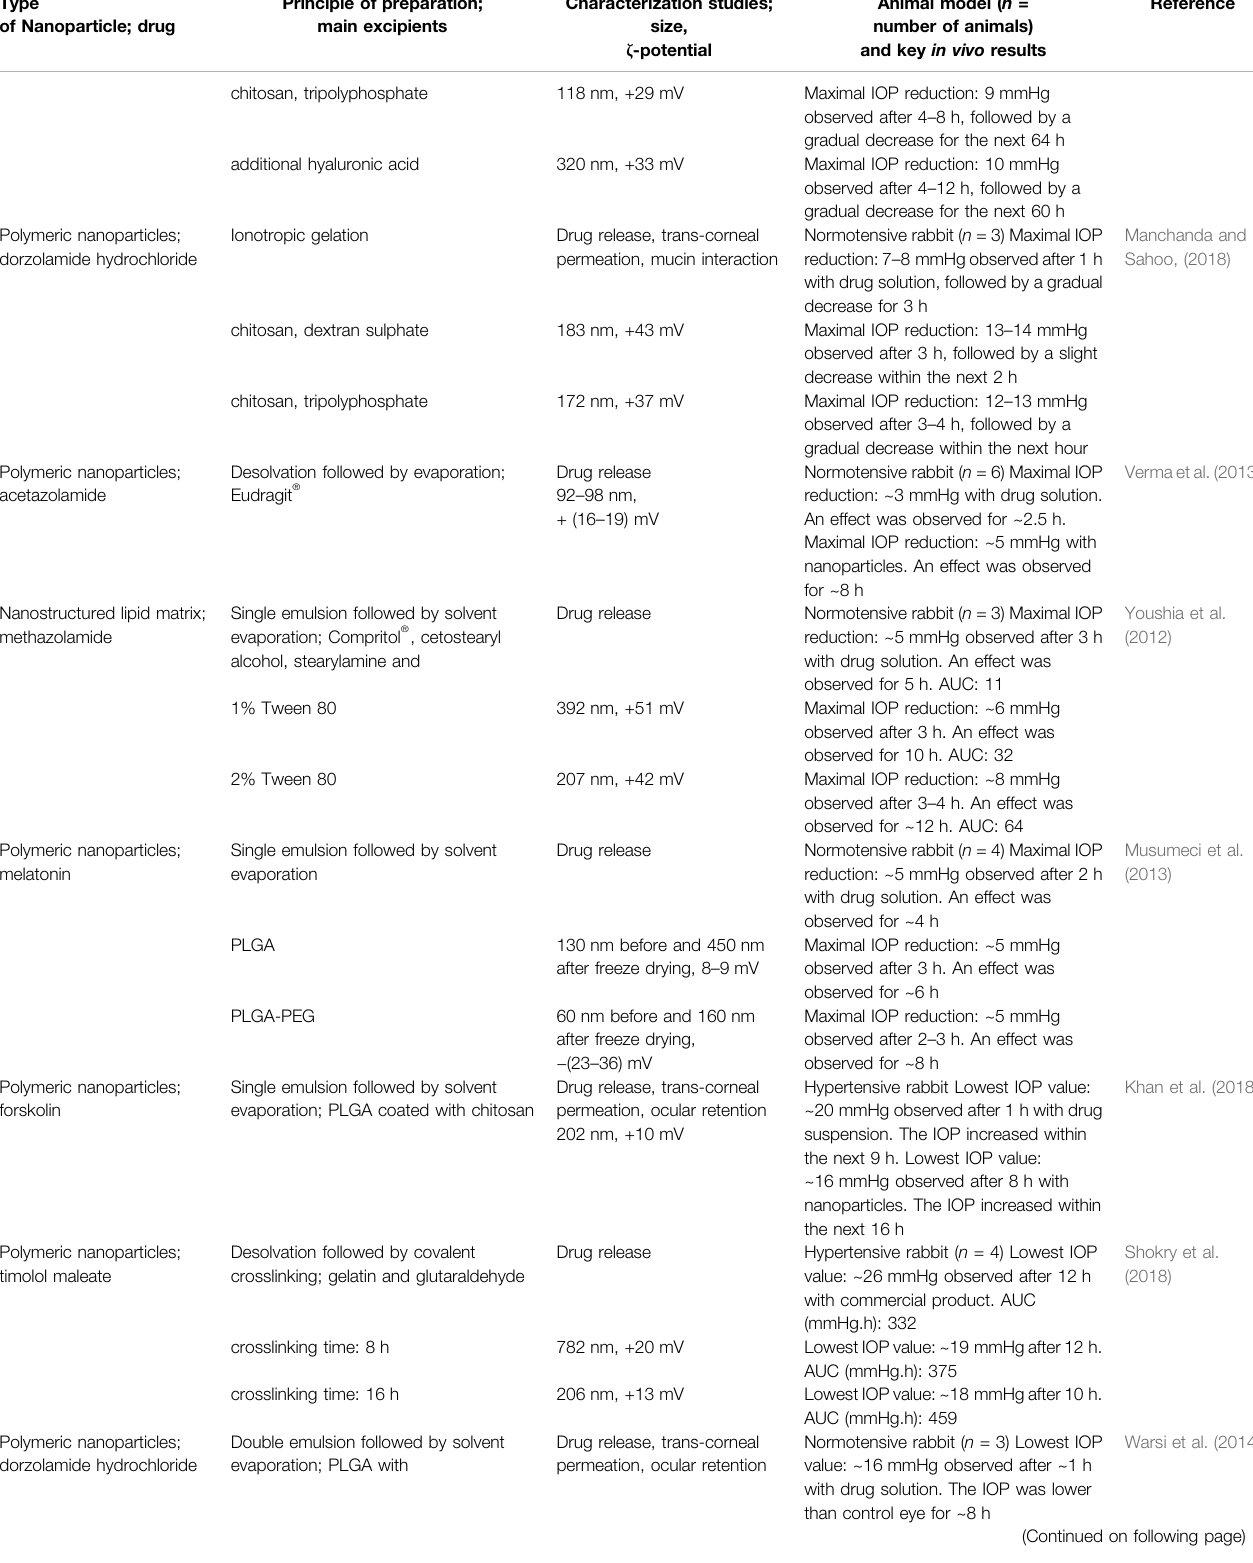
TABLE 4 | ( Continued ) Summary of in vivo studies on nanoparticle-based systems used for drug delivery to anterior segment of the